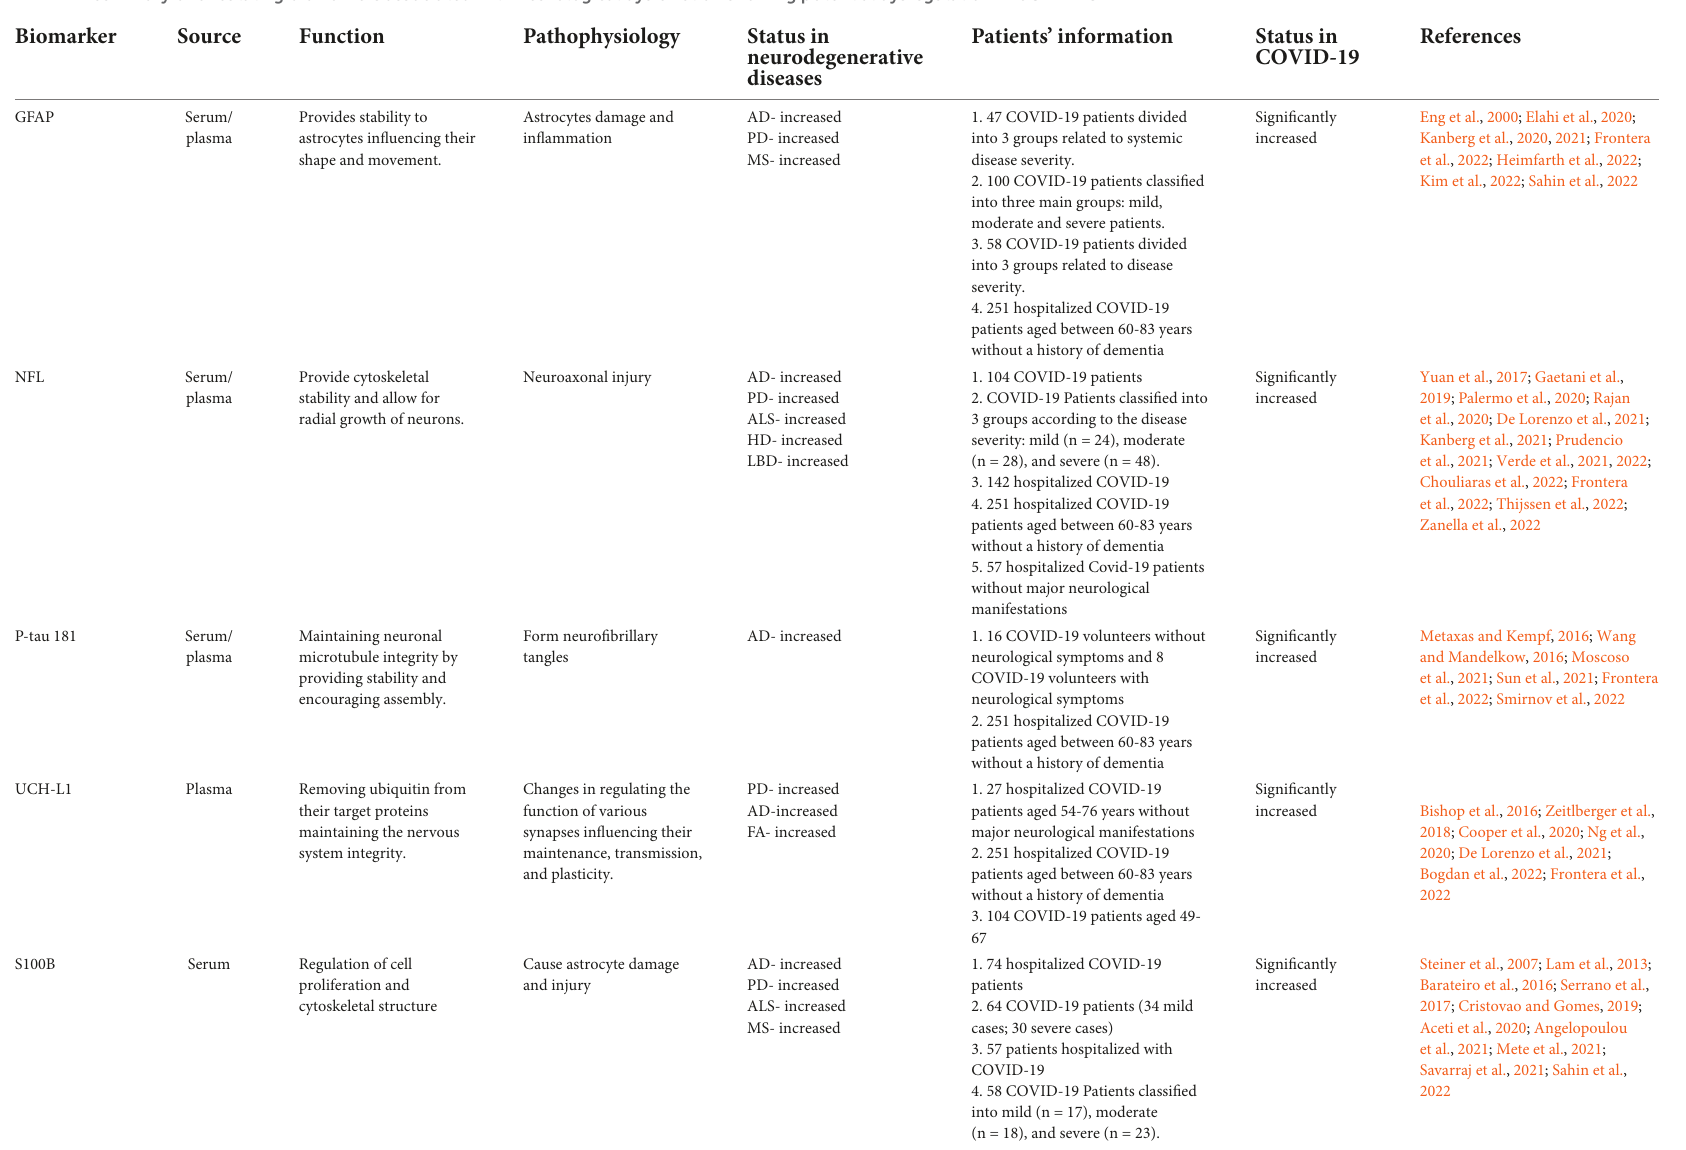
TABLE 1 Summary of circulating biomarkers associated with neurological dysfunction showing potential dysregulation in